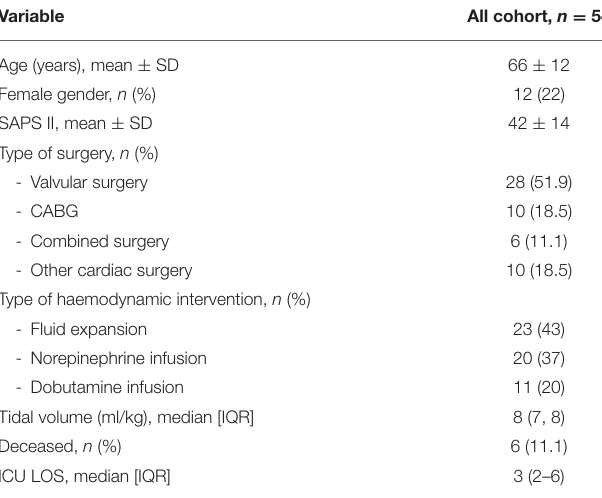
TABLE 1 | Patients’ general characteristics. TABLE 2 | Comparison of haemodynamic parameters before and after